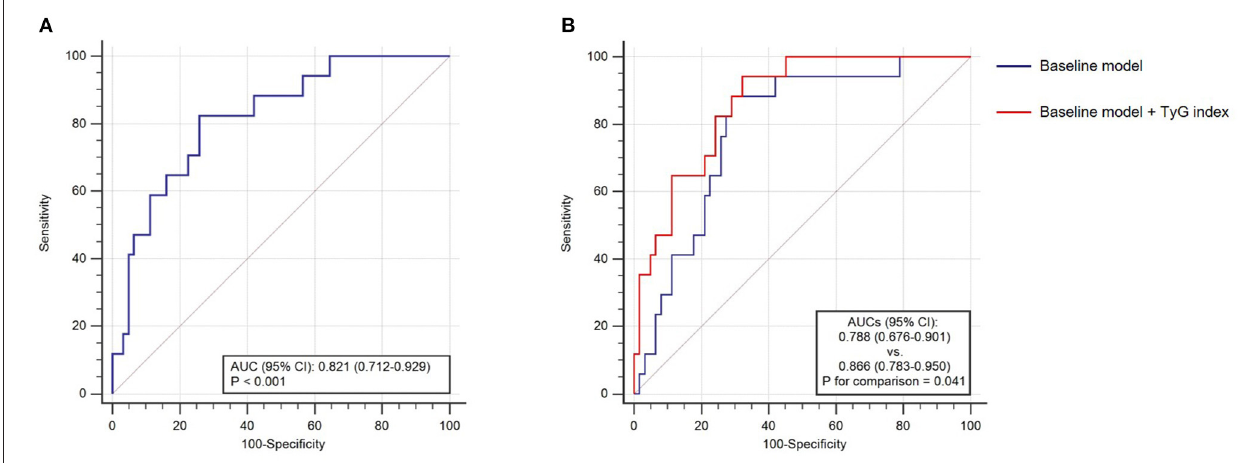
FIGURE 4 | The receiver operating characteristics (ROC) curve analysis. (A) The predictive value of TyG index for in-hospital death; (B) the incremental effect of TyG index on the prediction of in-hospital death. AUC, area under the ROC curve; CI , confidence interval; and TyG, triglyceride-glucose.